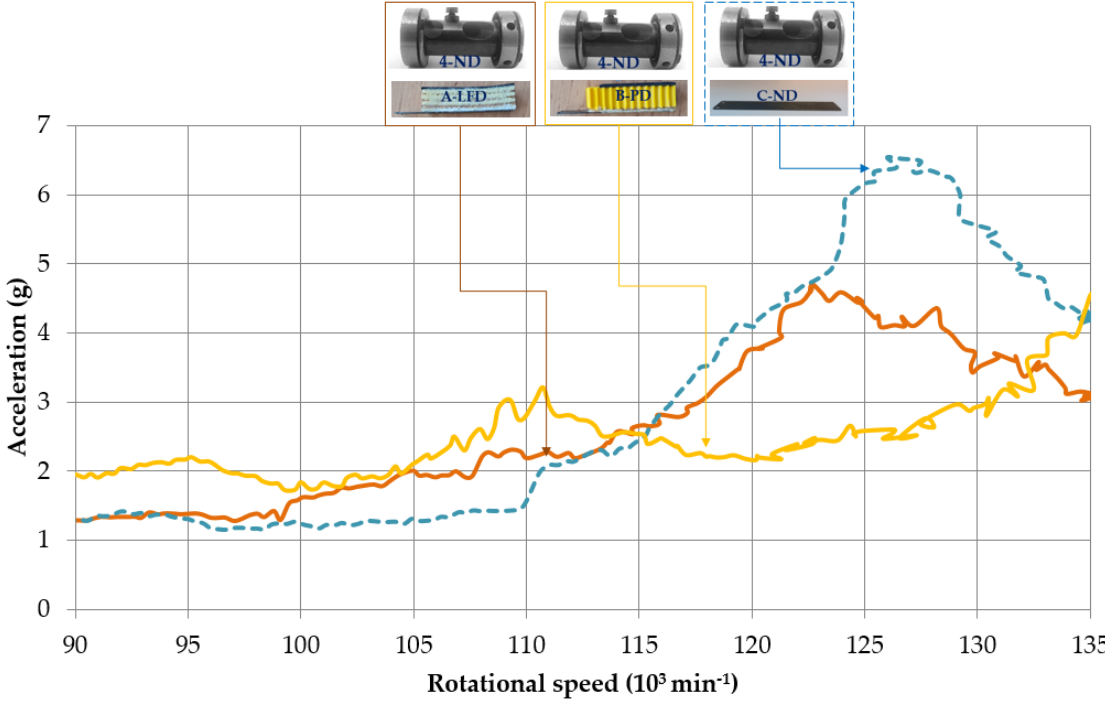
Figure 8. Dynamic responses of passive dampers with native rotor casings. Incorporating passive dampers and individual polymer particle composites in the rotor casing, the following results were obtained: A-LFD+1-CD, A-LFD+2-GSM, and A-LFD+3- SiS provided a reduction in average and maximum amplitudes (Figure 7). Compared to the native design C-ND+4-ND, the reduction in the average amplitude values in the range of 120,000–135,000 min − 1 was by 43.4%, 49.1%, and 47.2% (Table 2) for A-LFD+1-CD, A-LFD+2-GSM, and A-LFD+3-SiS, respectively. The original resonance peak was in the warning mode and the additional material in the form of a layered foam damper A-LFD decreased this in safe operation